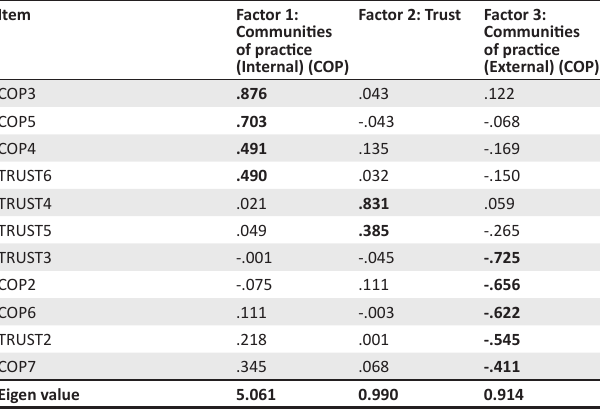
TABLE 3: Rotated factor loadings: Interpersonal